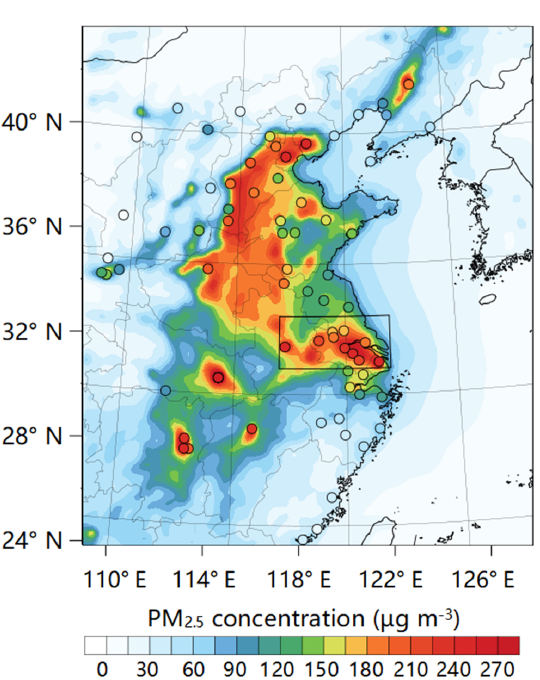
Figure 2. Spatial distribution of simulated (colored area) and ob- served (color-coded dots) mean PM 2 . 5 concentrations during 1–10 December 2013 over eastern China. The black rectangle denotes the YRD